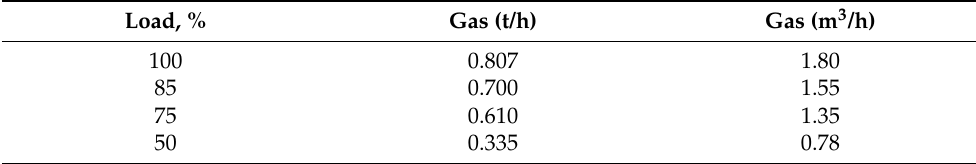
Table 6. LNG consumption at different loads.